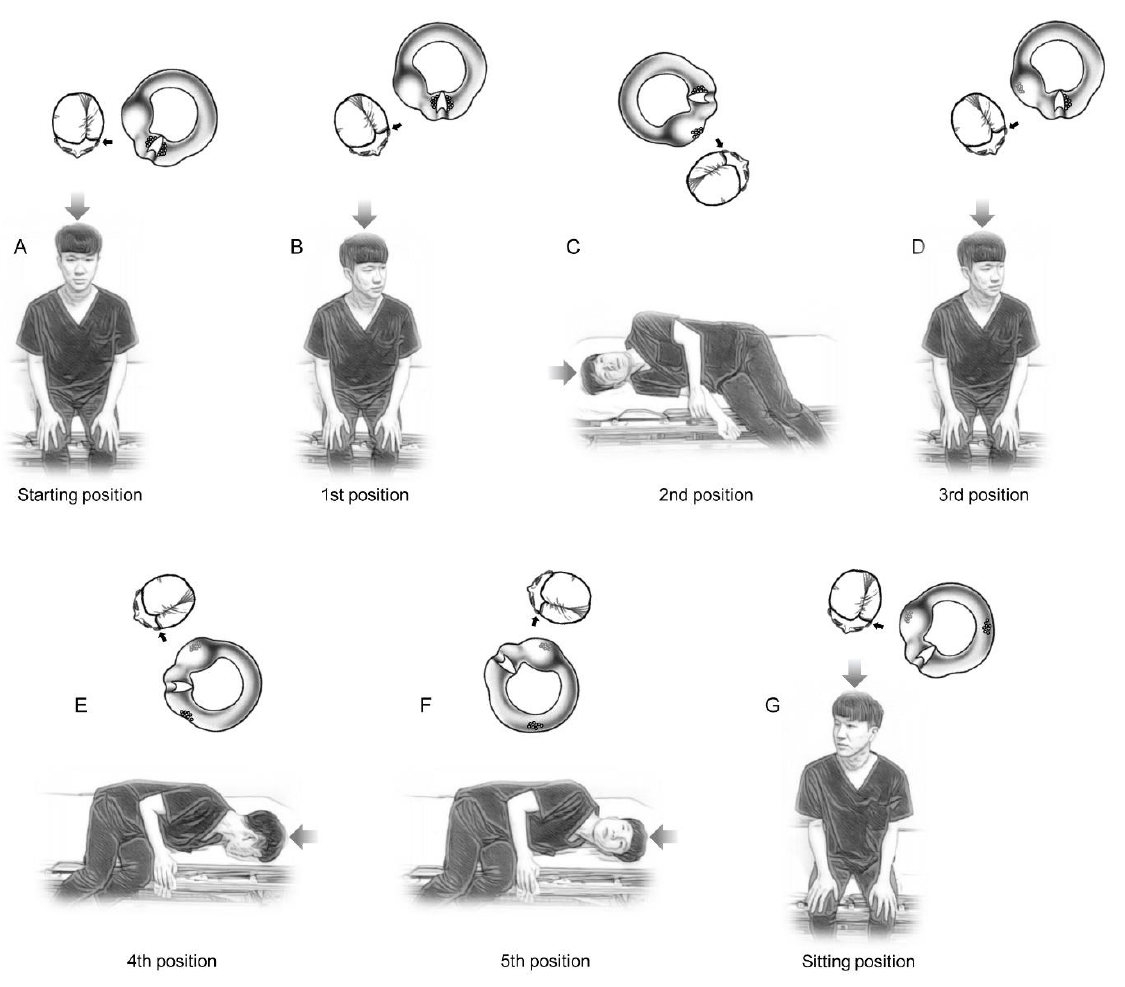
Figure 1. New repositioning maneuvers for treating left-sided horizontal semicircular canal (HSCC) cupulolithiasis. ( A ) The patient was seated in the center of the examination table. ( B ) The head was turned 30° to the affected side to align the affected side cupula axis to the sagittal plane (1 st position). ( C ) The patient was rapidly brought down on the healthy side and held for two min in that position (2nd position). ( D ) The patient was slowly returned to the sitting position and kept in that position for 1 min (3rd position). ( E ) The head was turned 30° to the affected side, then the patient was quickly brought down on the affected side and held for two min (4th position). ( F ) The head was quickly turned 45° upward and kept in that position for 2 min (5th position). ( G ) The patient was slowly returned to the sitting position (Figure 1G). At the top of each posture, the left (small black arrow) HSCC (viewed from the top of the head, large gray arrow) are expressed, and the supposed movement and detachment of the otolithic debris from the cupula are also demonstrated.